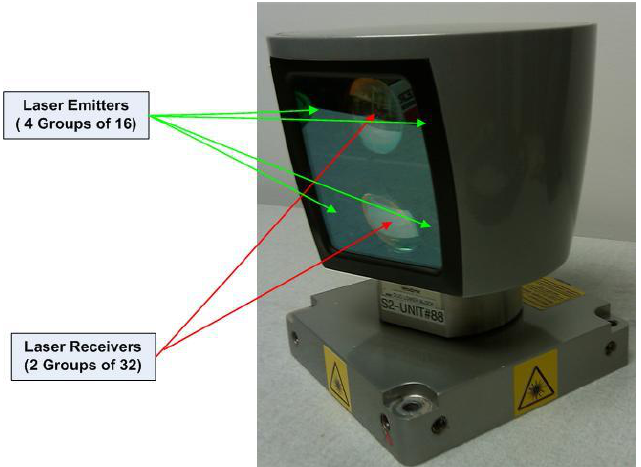
Figure 1. The Velodyne HDL-64E S2